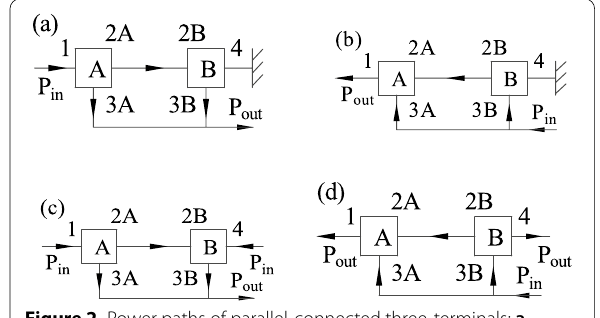
Figure 2 Power paths of parallel‑connected three‑terminals: a 1‑DOF Split output, b 1‑DOF Split input, c 2‑DOF Split output, d 2‑DOF Split input